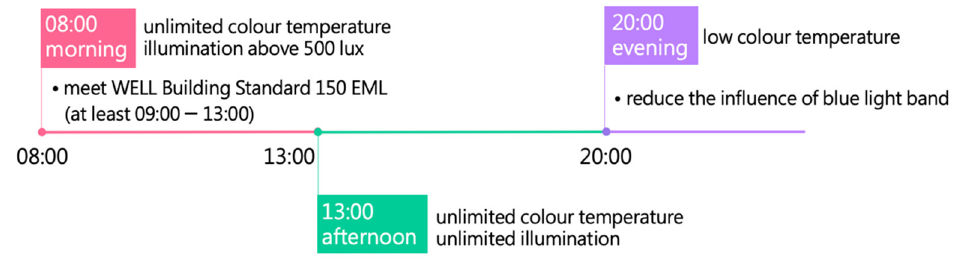
Figure 8. Proposal for healthy lighting control strategy.